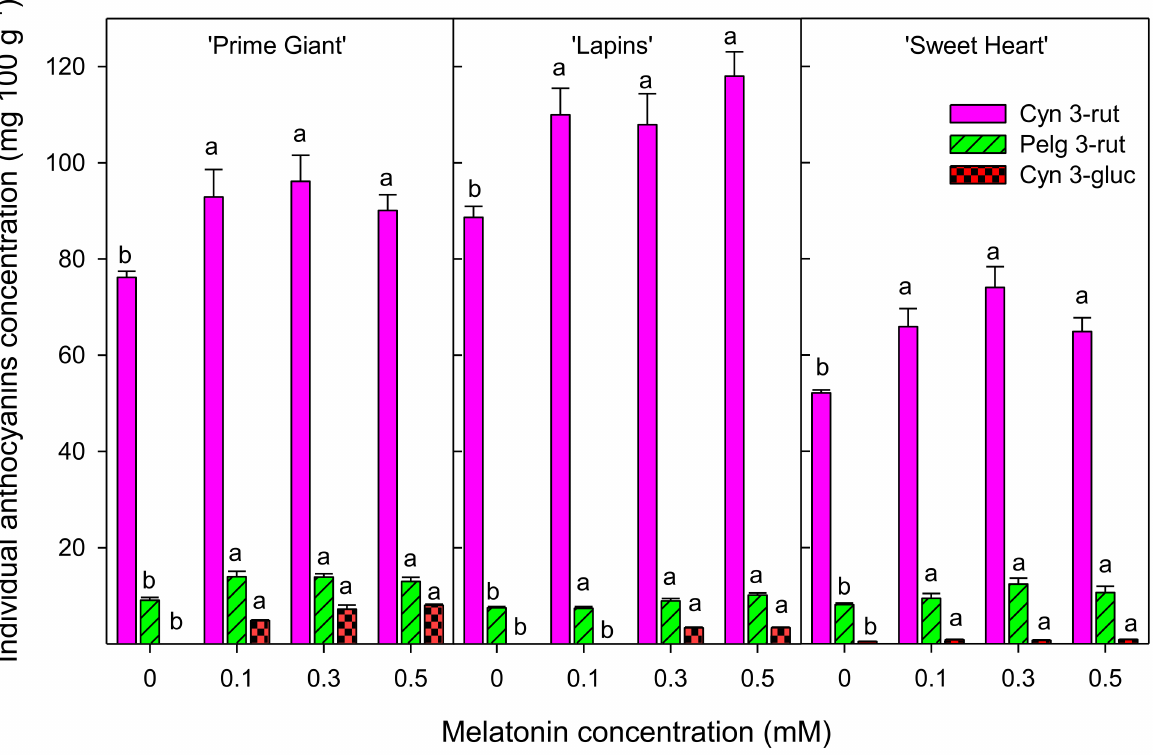
Figure 6. Individual anthocyanins concentration (cyaniding 3-rutinoside, cyn 3-rut, pelargonidin 3-rutinoside, pelg 3-rut, and cyanidin 3-glucoside, cyn 3-gluc) in sweet cherries from control and melatonin-treated trees in the 2020 experiment. Data are the mean ± SE of determinations made in duplicate in three replicates. Different letters show significant differences ( p < 0.05) between treatments for each